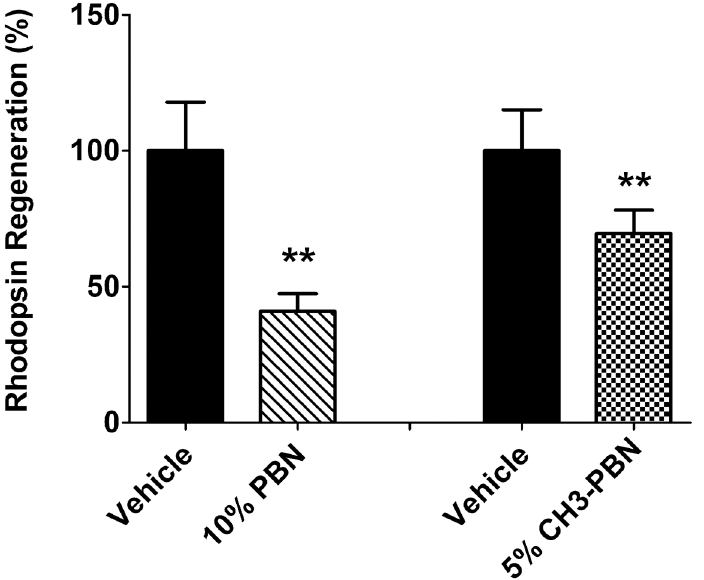
Fig 6. PBN and 4-CH 3 -PBN topically administered in baboon eyes slows rate of rhodopsin regeneration. Baboon eyes were treated topically with drug or vehicle every 15 minutes over a 2h period before eyes were harvested and dark adapted 2h before retinal harvest. 10% PBN showed a roughly 50% higher inhibition rate compared to 5% CH 3 -PBN suggesting both drugs to be effective. [ ** = p < 0.001; n = 6 –